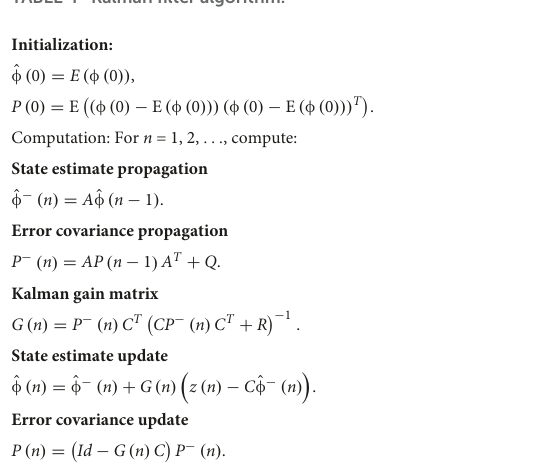
TABLE 4 Kalman filter